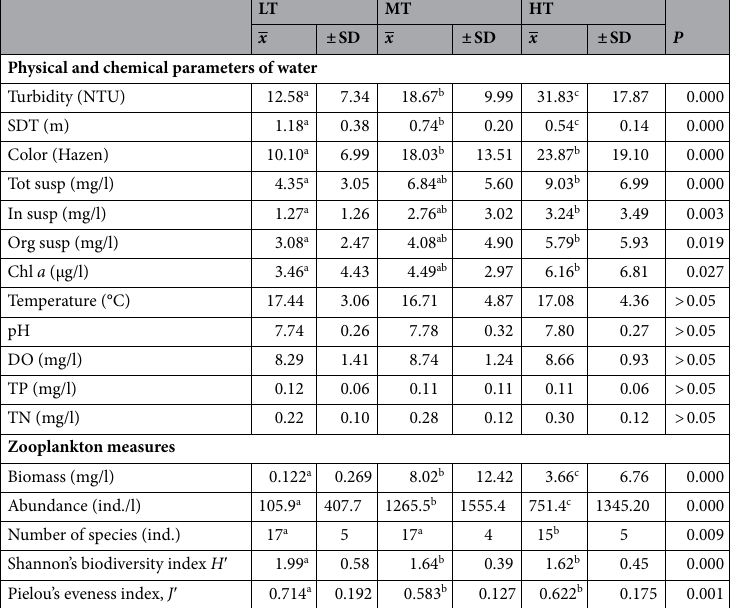
Table 1. Water quality and zooplankton parameters across the studied turbidity classes (mean ± SD). Differences in the analysed parameters were determined by ANOVA (df = 157; P ≤ 0.05); values with the different superscripts are different among reservoirs by post-hoc Tukey test. SDT Secchi depth, Tot susp total suspended solids, In susp inorganic suspended solids, Org susp organic suspended solids, Chl a chlorophyll a , DO dissolved oxygen, TP total phosphorus, TN total nitrogen.